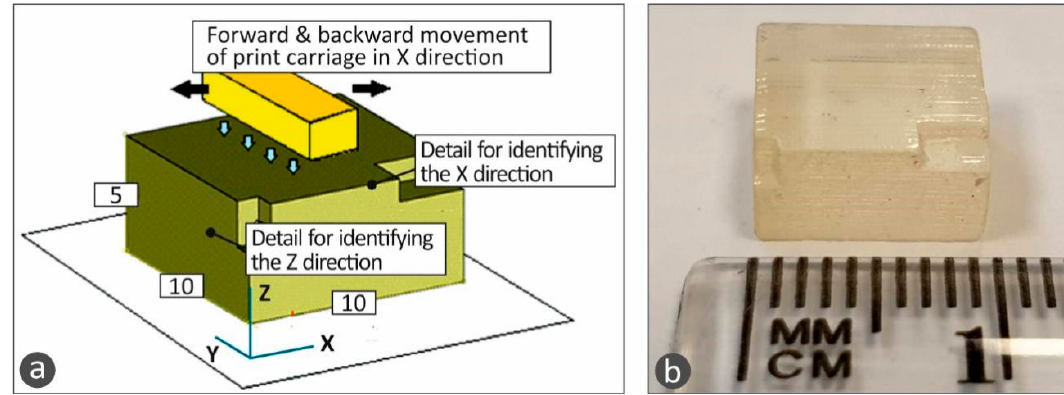
Figure 3. ( a ) Basic specimen dimensions and shape details for identifying the X, Y, and Z directions, after build. ( b ) “Striped surface” result, due to knife movement.